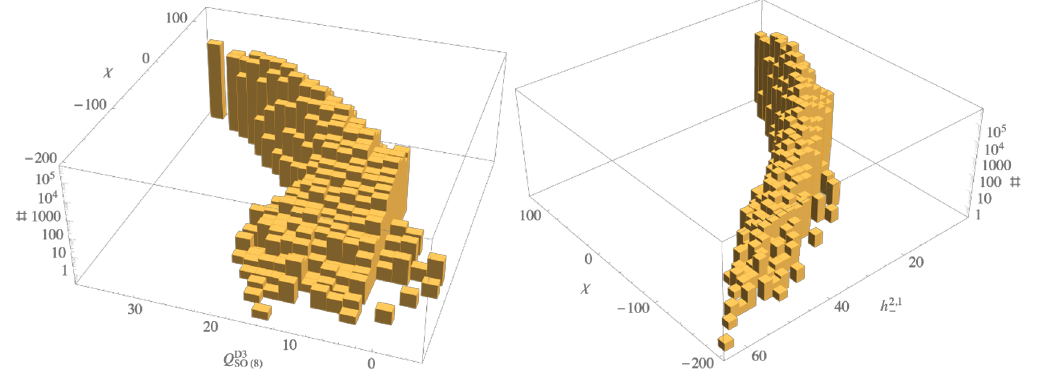
Figure 5 . Histograms showing on a logarithmic scale the number of orientifolds. Left: count for each value of ( Q D 3 ; (cid:31) ). Right: count for each value of ( h 2 ; 1 SO(8) islands embedded in large otherwise empty